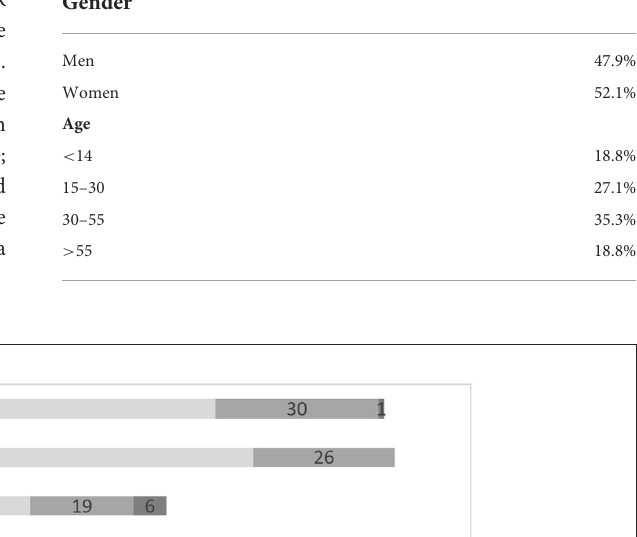
TABLE 2 Information of participants.